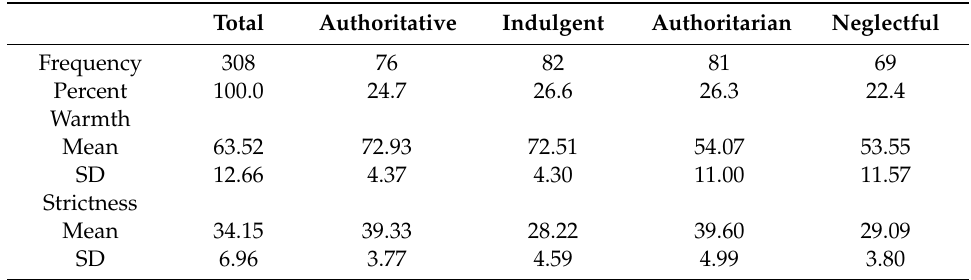
Table 1. Distribution of families according to parenting style, means ( M ), and standard deviations ( SD ) on parental warmth and